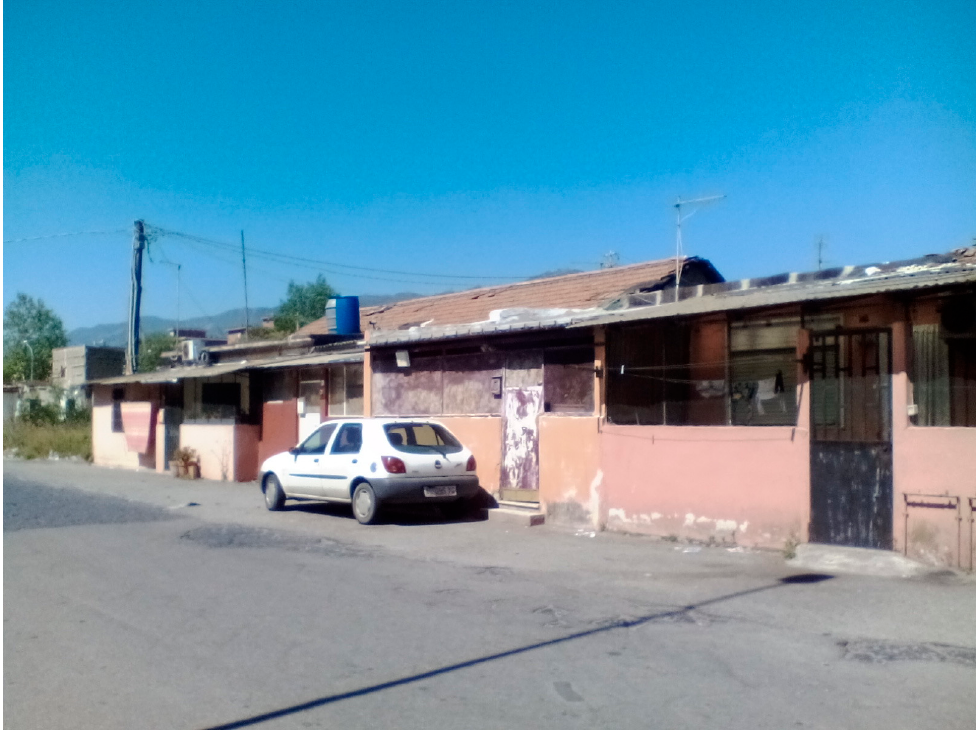
Figure 3. An image of the shanties before the urban regeneration intervention (2015) .